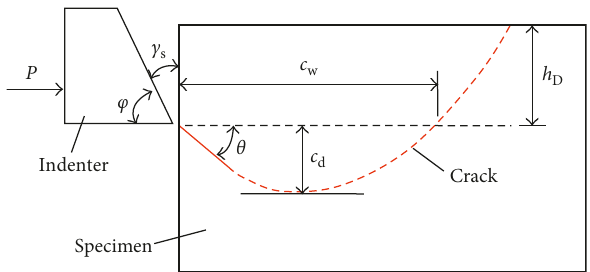
Figure 8: Parameters of crack initiation and propagation path.